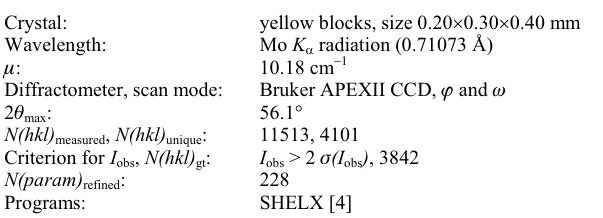
Table 1. Data collection and handling.